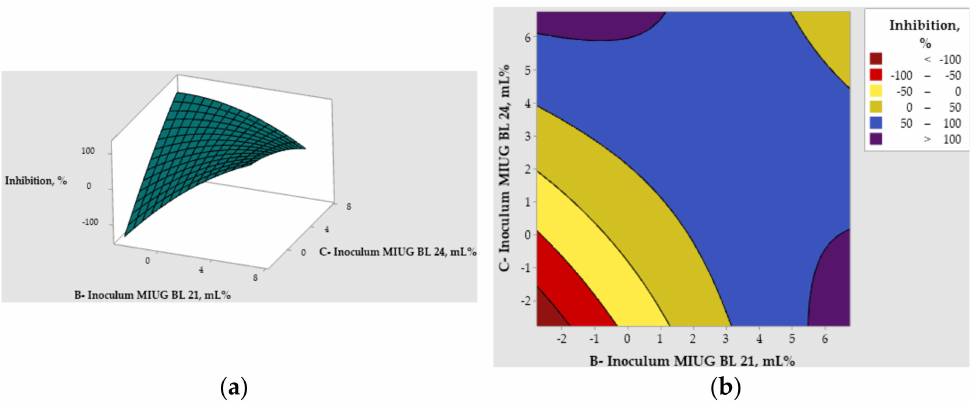
Figure 3. Surface ( a ) and contour ( b ) plots for the two-way interactions between the significant fermentation variables B and C , on the antifungal activity (inhibition ratio, %) against Penicillium spp. The mean of the factors A to F is given in Table 2.